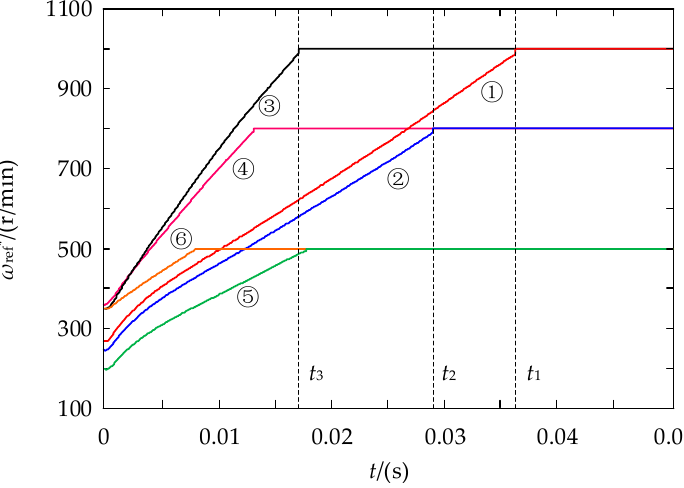
Figure 8. Softened speed under different operating conditions.